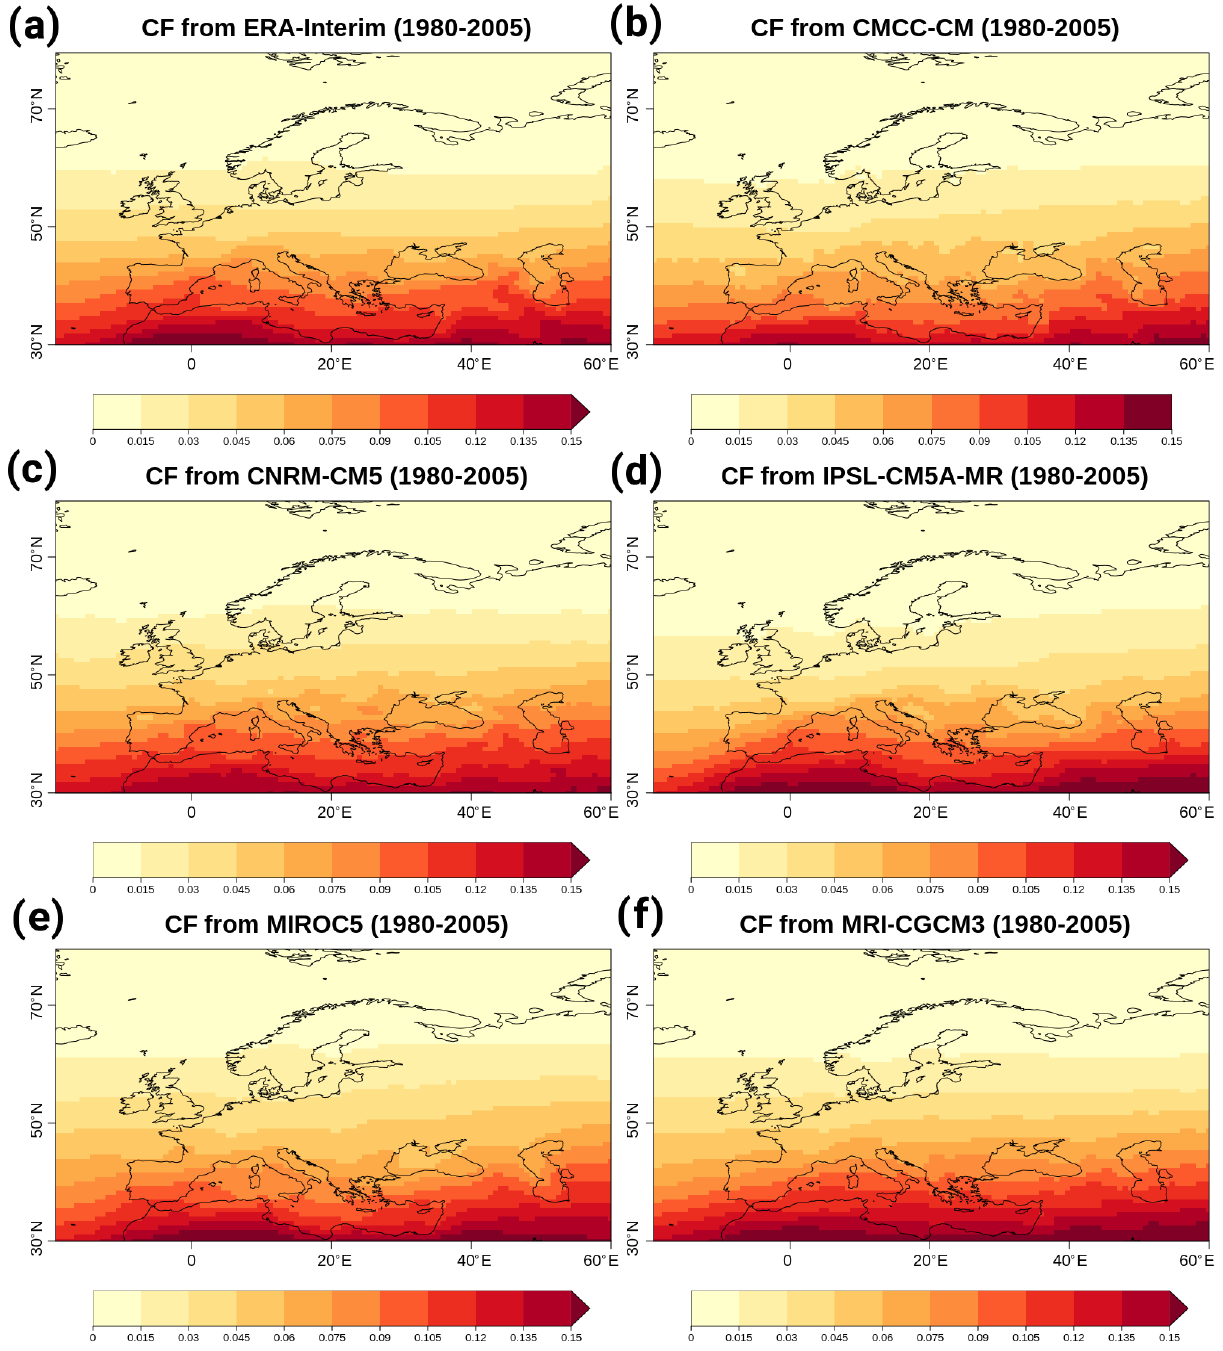
Figure 12. Photovoltaic capacity factor during the DJF period 1980–2005 using ERA-Interim (a) , CMCC-CM (b) , CNRM-CM5 (c) , IPSL- CM5-MR (d) , MIROC5 (e) , and MRI-CGCM3 (f) (see Sect. 3.3.4 for details on recipe_pv_capacity_factor.yml ).